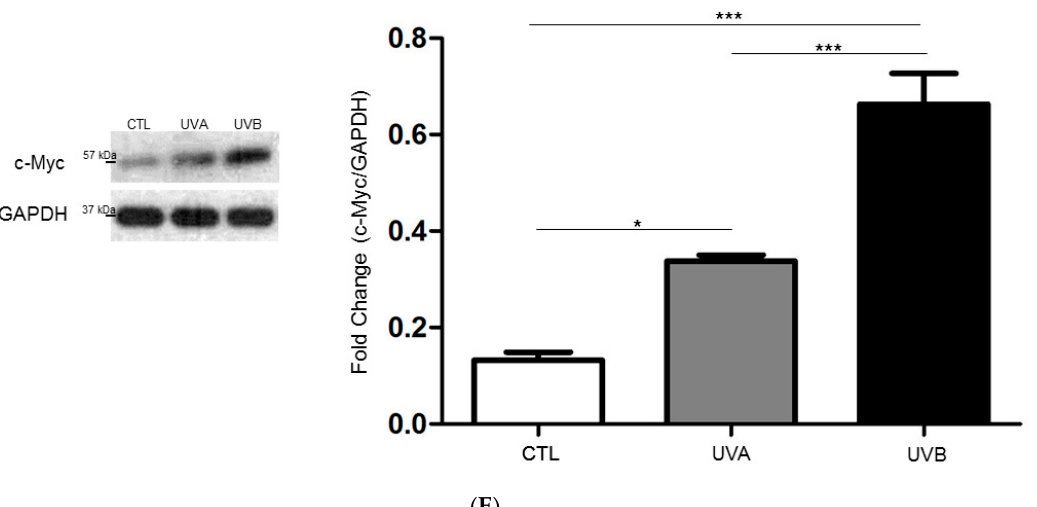
Figure 5. Validation of the protein changes with proteome study and biological network analysis. ( A ) Characteristic two-dimensional electrophoresis (2-DE) protein profiles of nude mouse skin. Each spot volume was determined and quantified by silver-staining (Prodigy SameSpots software). The protein spots with significant difference in volume are marked with Arabic numbers. ( B ) The expression level of HSP27 was verified by immunohistochemical experiment. The quantification of protein volume was determined with the Image Pro-Plus 4.5 computer program and presented by the bar chart. (** p < 0.01; *** p < 0.001). ( C ) Biological network analyses of differentially expressed proteins using MetaCore software. Nodes indicate proteins and lines between the nodes show direct protein–protein interplays. The different proteins on this map are represented by different symbols reflecting the functional class of the proteins. ( D ) Confirmation of the data of the c-Jun signal derived from the network analysis and the expression of c-Jun was denoted by red arrows. ( E ) The level of c-Myc was surveyed with the Western blot analysis and glyceraldehyde 3-phosphate dehydrogenase (GAPDH) was used as a loading control. The quantified results were demonstrated by the bar chart. (* p < 0.05; *** p < 0.001).